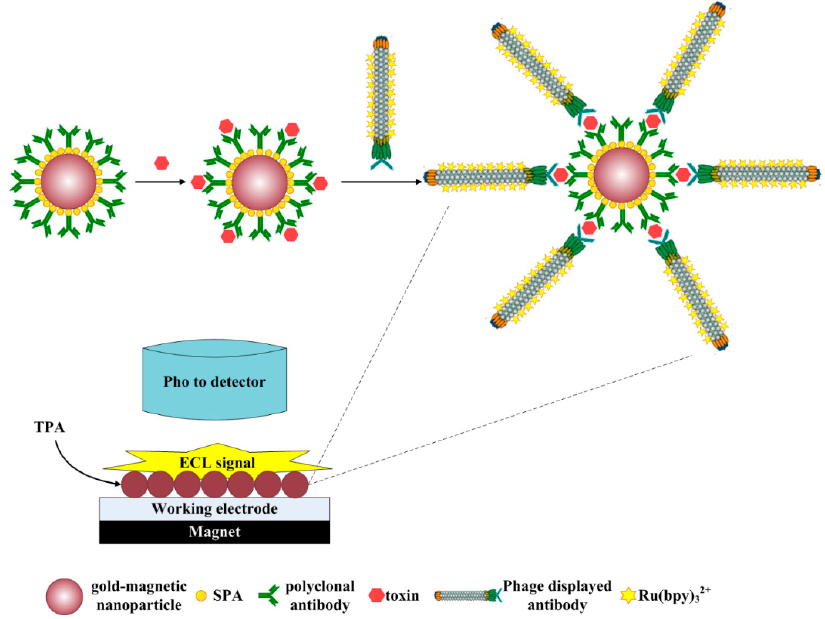
Figure 1. Model of detection toxin by ECL immunosensor based on gold-magnetic nanoparticles and phage displayed antibody. phage displayed